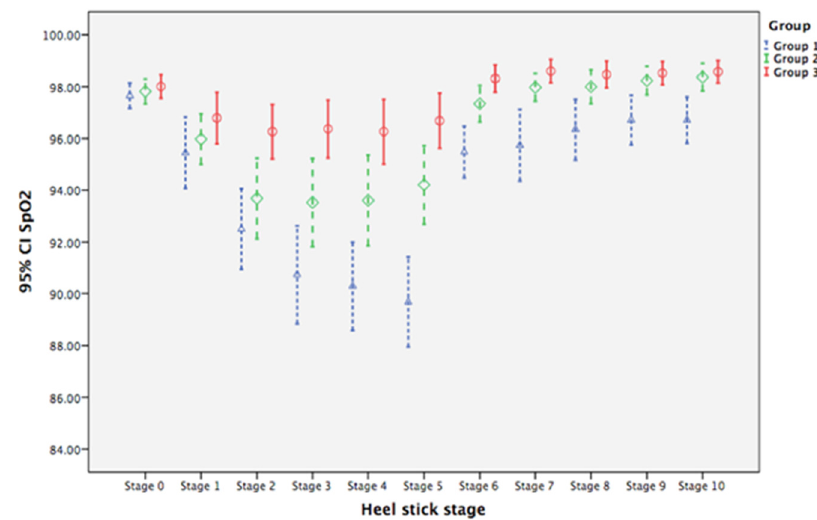
Figure 4. Clustered error-bar graphs showing time trends of mean oxygen saturation (SpO 2 ) with 95% confidence intervals (CI) for neonates in the three treatment groups over heel-prick stages. Groups: 1 (blue), gentle touch plus human voice (control condition); 2 (green), control condition + breast milk odor; 3 (red), control condition + breast milk odor + breast milk taste by syringe feeding; Stage 0, baseline (no stimulation); Stages 1 to 4, the 1st to the 4th minute during heel prick, respectively; Stages 5 to 10, the 1st to 6th minute after completion of heel prick, respectively.